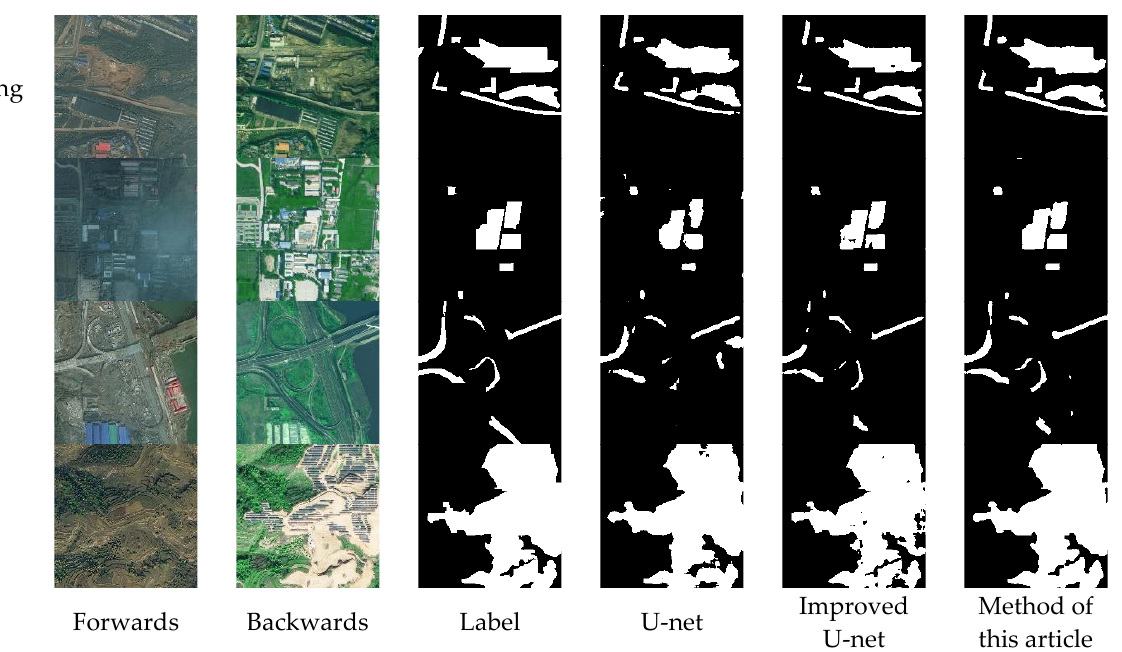
Figure 9. Extraction results of some newly added construction land.